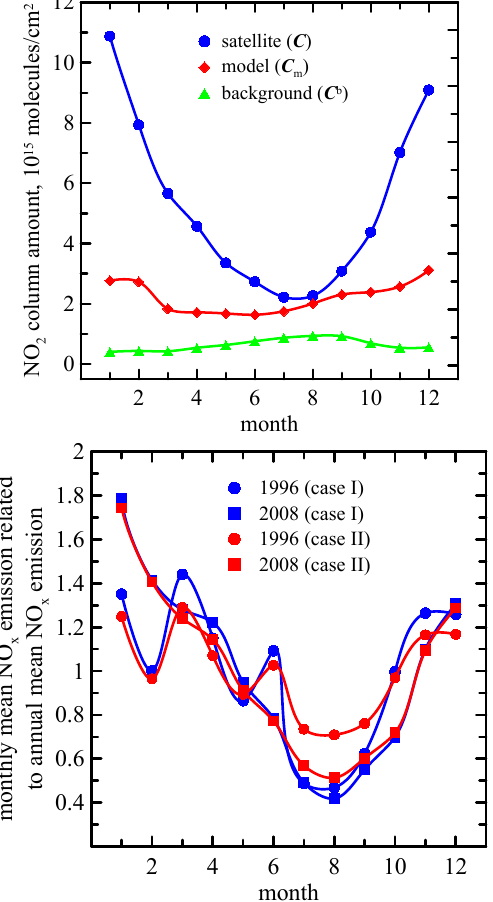
Fig. 6. The seasonal variation in NO 2 column amounts derived from satellite measurements ( C ) and simulated with CHIMERE with ( C m ) and without anthropogenic NO x emissions ( C b ) in China (a) and the estimated seasonal cycle of anthropogenic NO x emissions in 1996 and 2008 for cases I and II of the estimation method (b) . The NO 2 columns and NO x emissions are averaged over the eastern China region shown in Fig. 3a. Note that C m are calculated without any seasonal variation in anthropogenic emissions. Note also that oscillations in the plot (b) are most probably due to uncertainties in the monthly emission estimates.